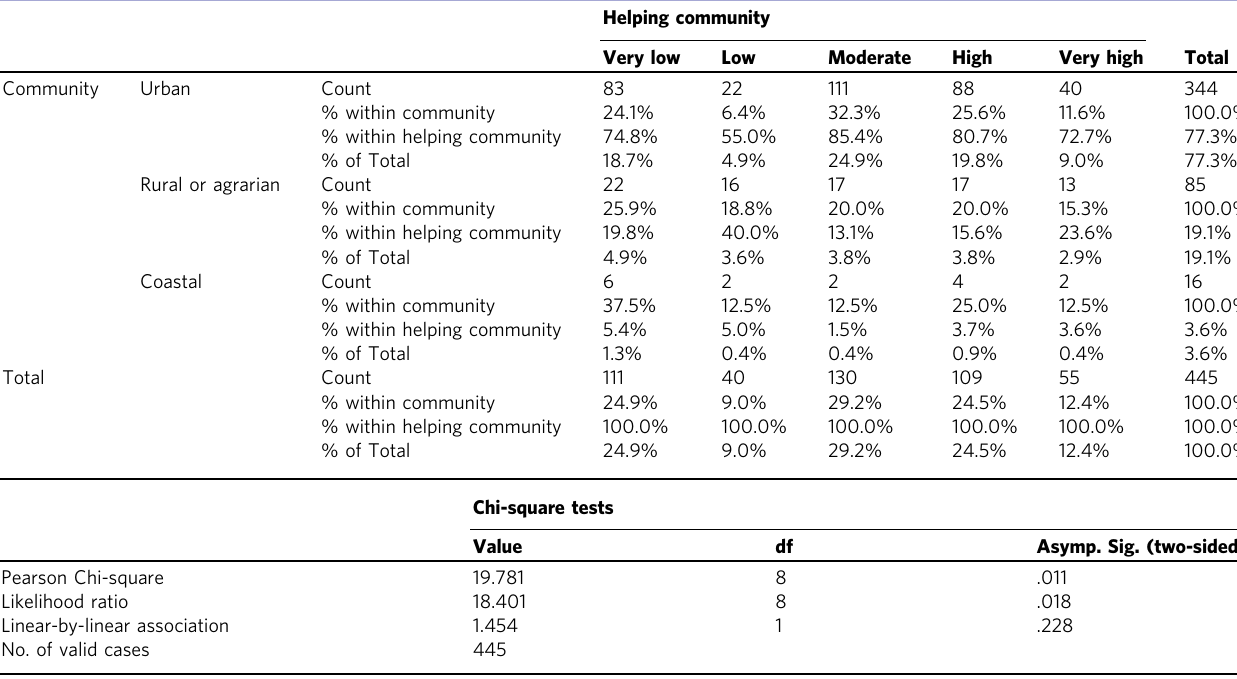
Table 2 Relations of geographical locations and level of solidarity using cross-tabulation and chi-square